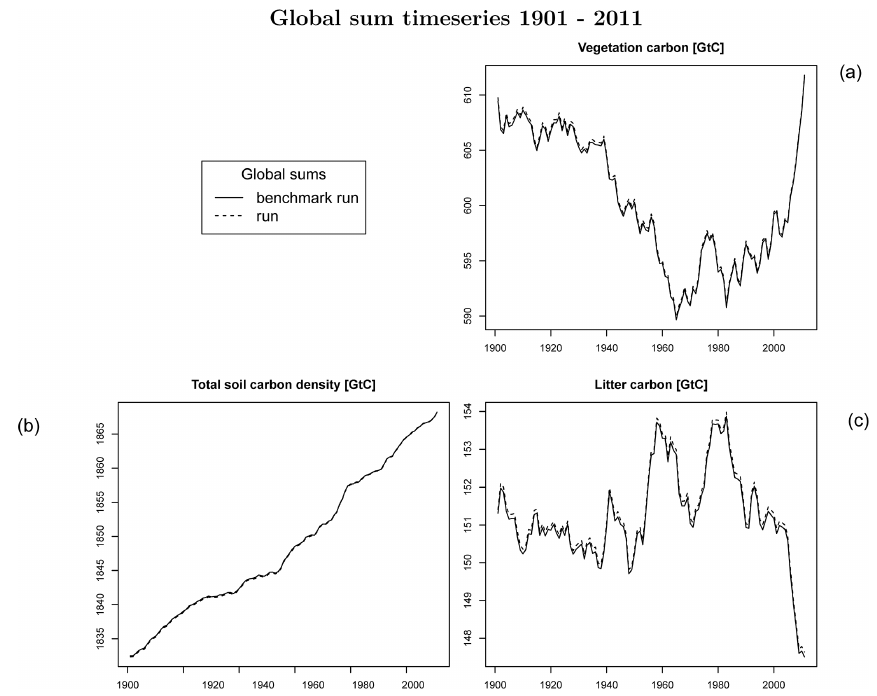
Figure C1. Global number for (a) vegetation carbon, (b) total soil carbon, and (c) litter carbon.